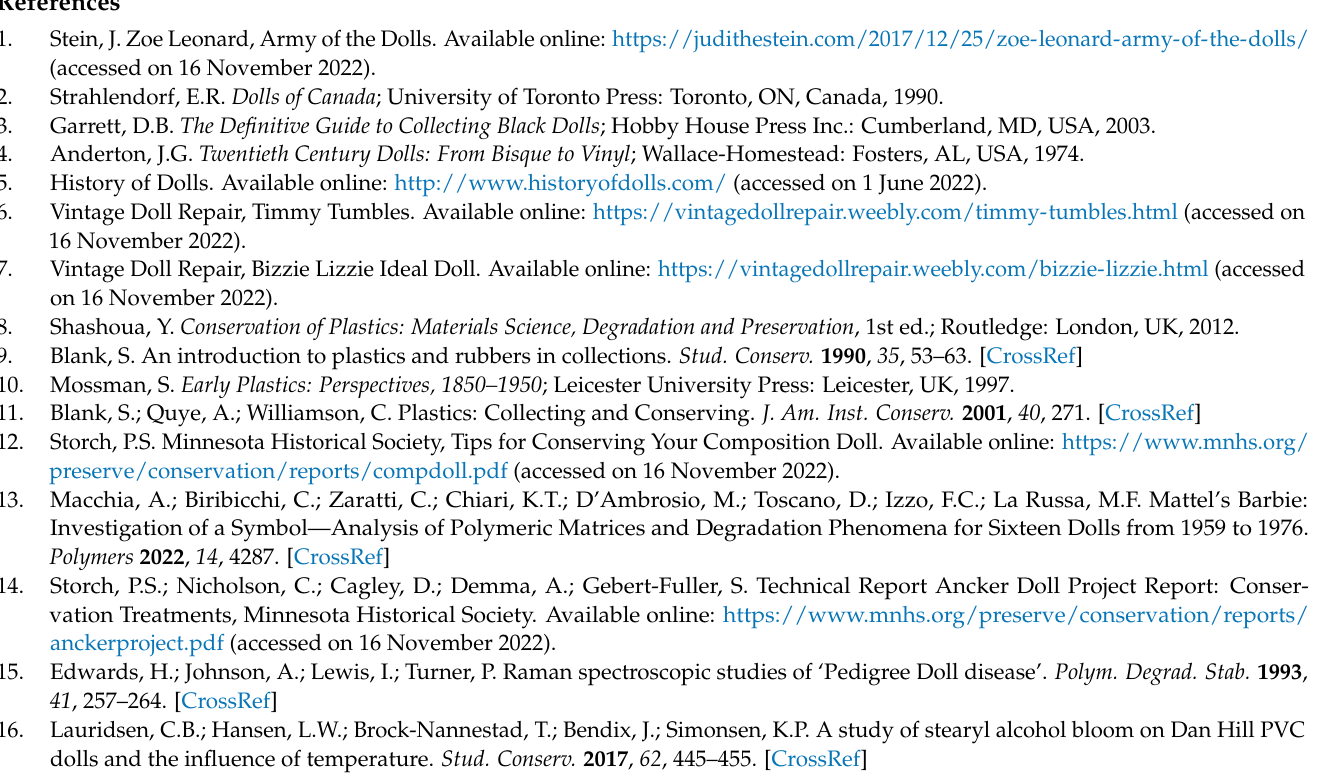
the CA arm; Figure S13: (a) Details of dolls G11 PS leg with flaking NC paint layer (b) Doll I14, showing cracking of (likely PE) legs which may worsen during handling and display. (c) crystal deposits on surface of arm, S.I. File 2, an Excel spreadsheet containing ER-FTIR data of reference plastic standards used to aid data